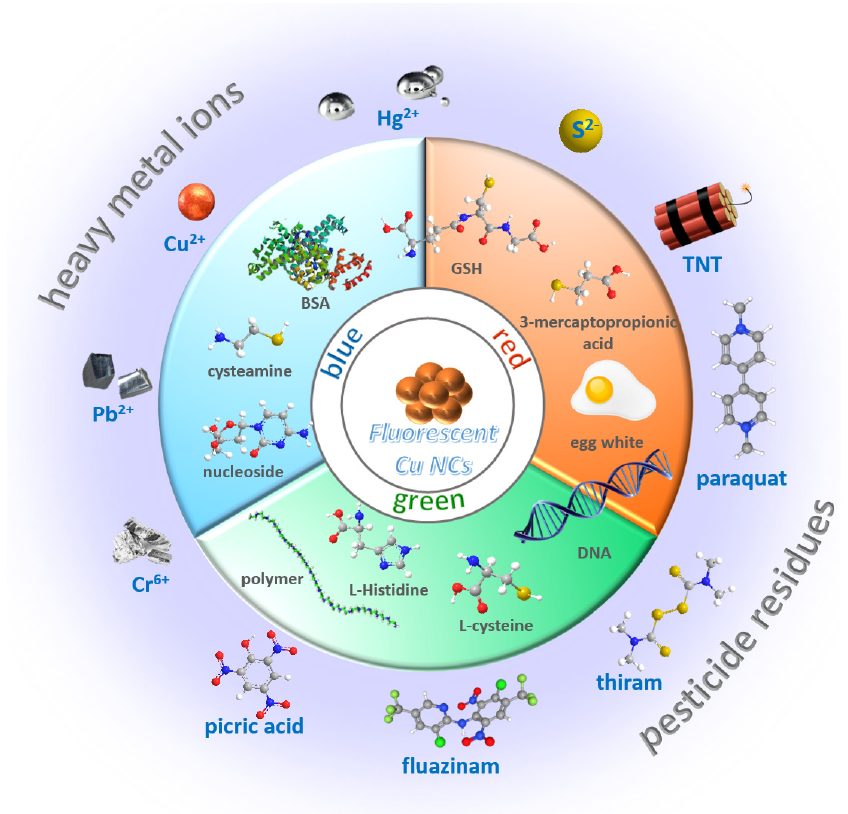
Scheme 1. Summary of ligands and templates for Cu NCs and their typical